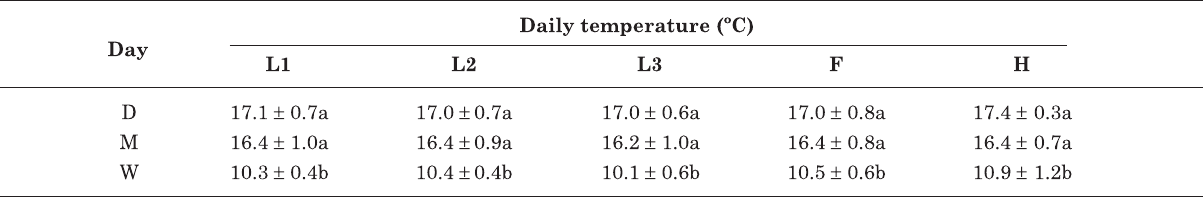
In the same day or in the same column, values followed by different letters are significantly different (*p <